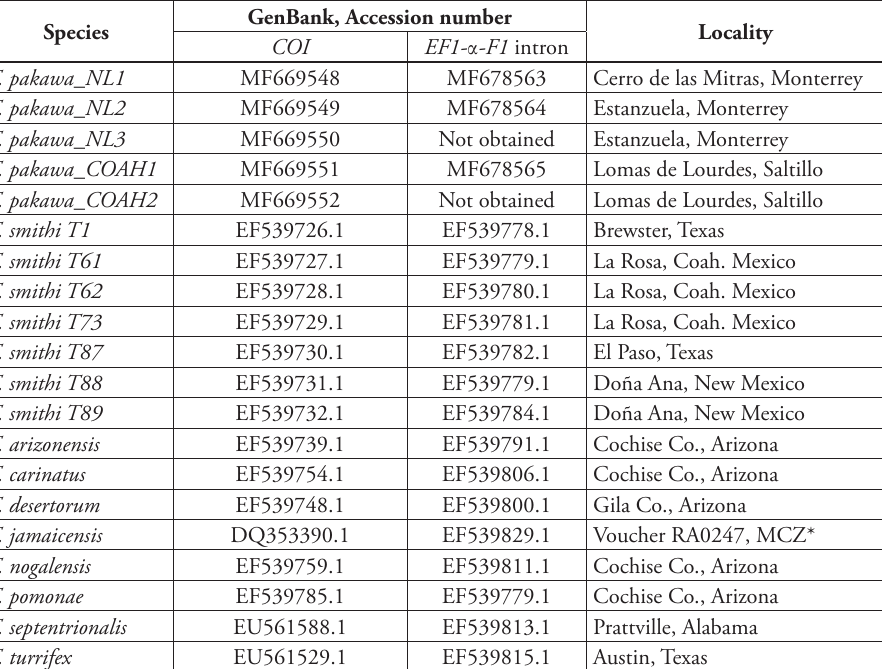
Table 1. Trachymyrmex species, accession numbers of COI and intron of EF1 α -F1 fragment sequences used in the Bayesian phylogenetic and haplotype network analyses, and collection localities of T. pakawa and T. smithi specimens